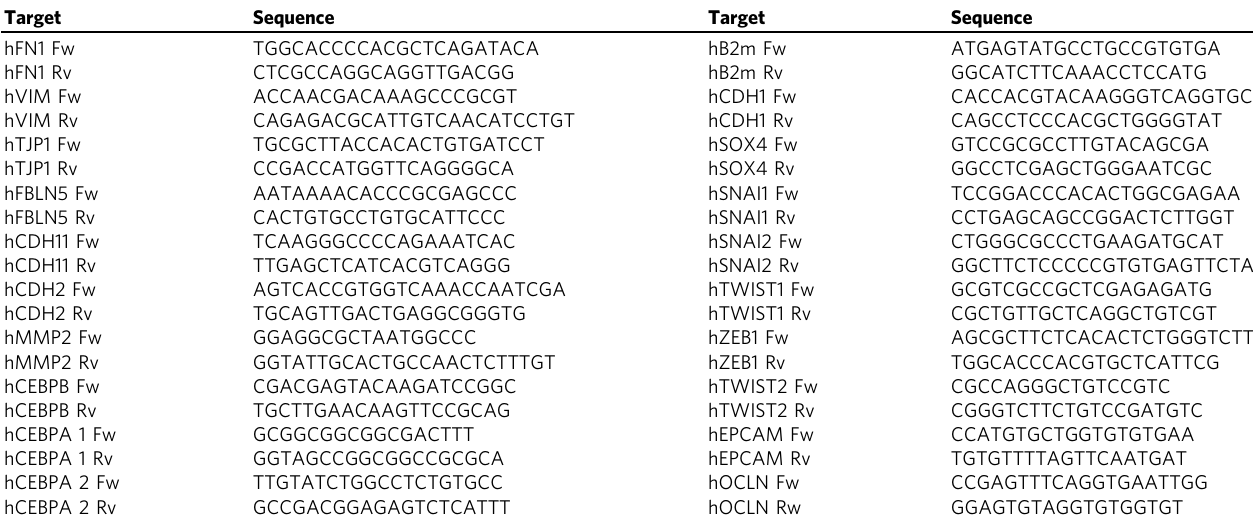
Table 1 List of primers used for